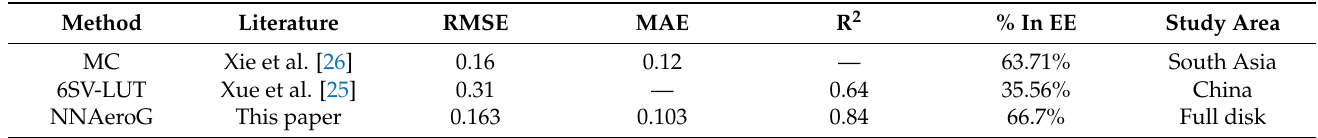
Figure 4. The comparison of the results for FY-4A/AGRI AOD using NNAeroG over veg- etated areas with other published results using other methods is presented in Table 5. Table 5. Overview of published AOD validation studies over vegetated areas for different methods applied to FY-4A/AGRI data.